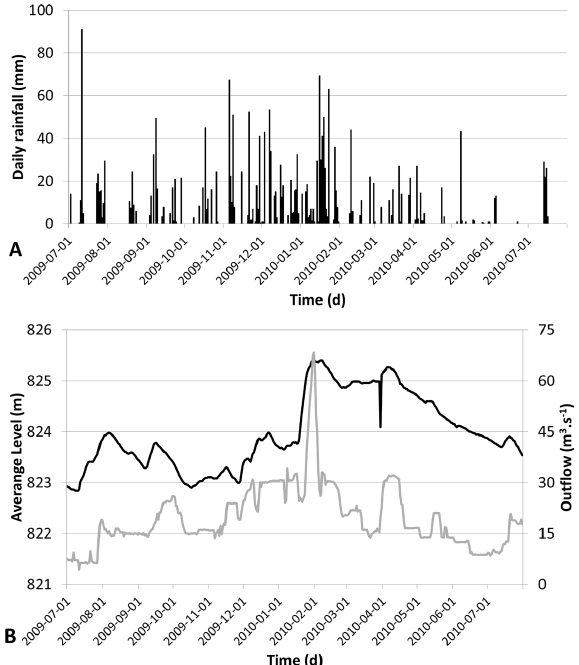
Figure 2. Climatological data of the Itupararanga Reservoir from June, 2009 to June, 2010. (A) Daily rainfall; (B) Water level (black line) and outflow (diffluent flow – gray line) Source: Votorantim